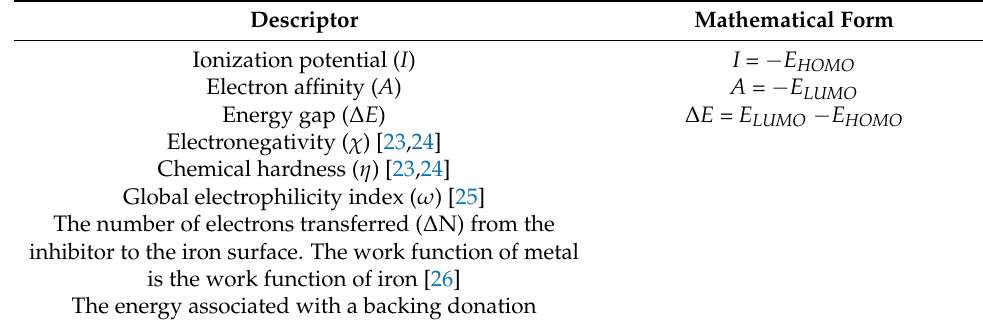
Table 1. The mathematical forms for estimating quantum chemical descriptors.